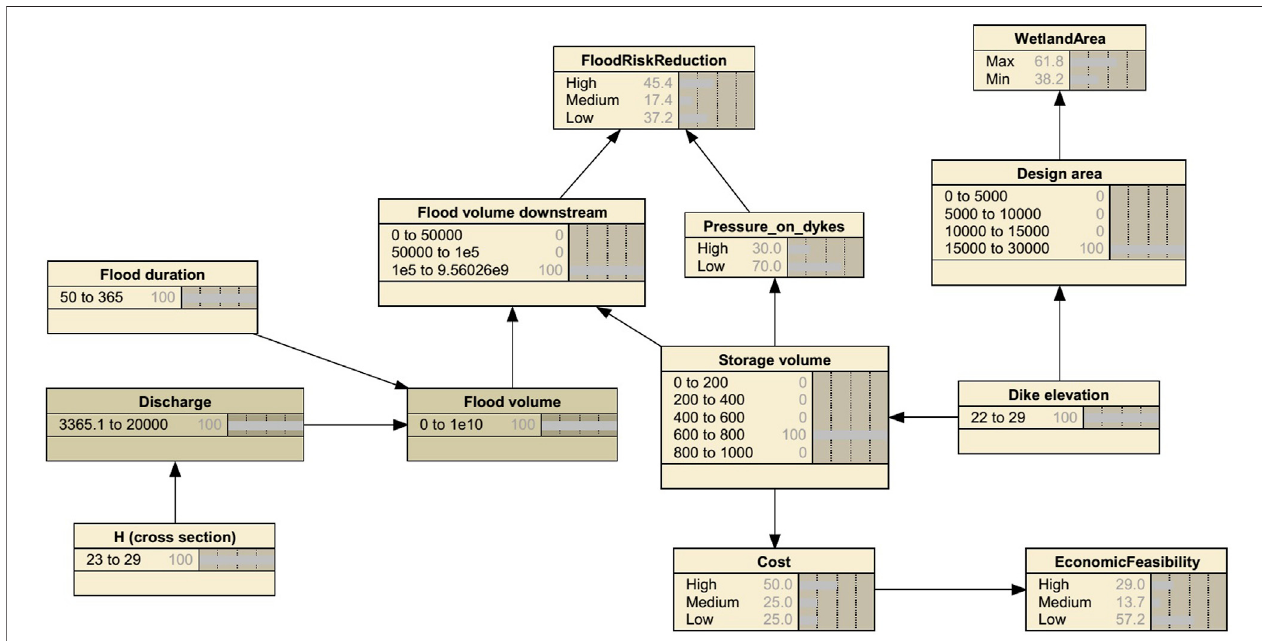
FIGURE 7 | Flood risk assessment part of the BBN.